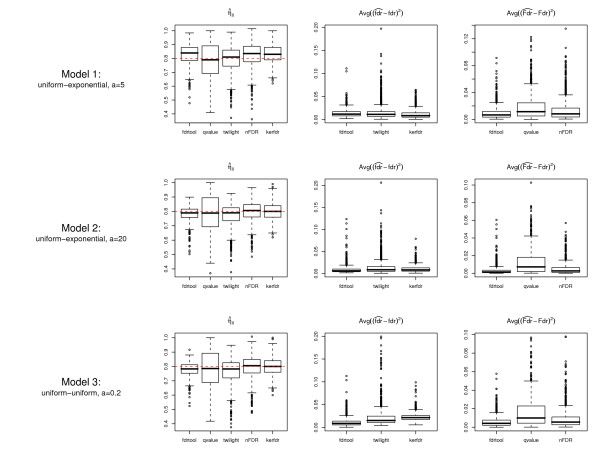
Comparison of the estimates of the proportion of null p-values and the squared error of Fdr and fdr for various p-value-based FDR estimation procedures under three different simulation scenarios. The box plots summarize the estimates from B = 1000 repetitions of the simulations. The sample size (i.e. the number of multiple tests) was m = 200.